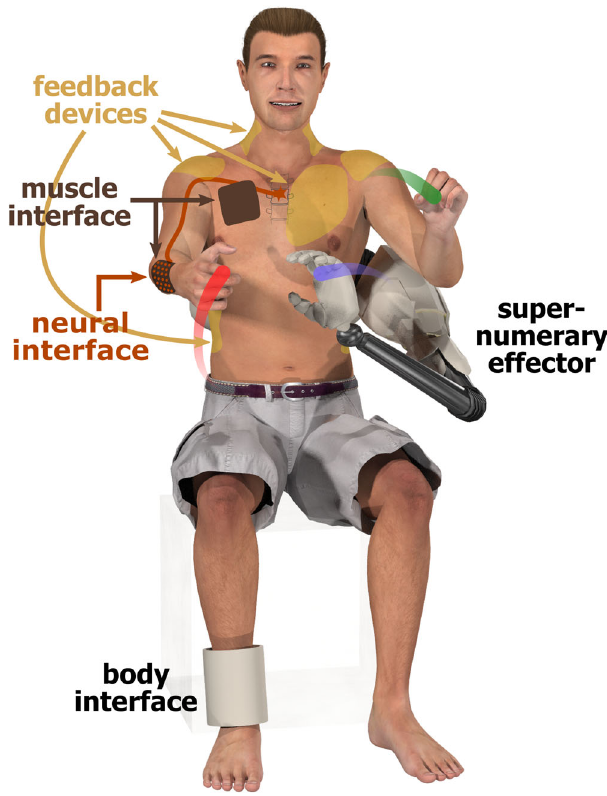
Fig. 3 Interfaces for DoF augmentation ( fi gure by Tobias Pistohl). An individual is augmented using a body, muscle or neural interface to control the supernumerary effector. Sensory information may be provided through feedback devices. The interfaces, supernumerary effector and feedback devices are shown at representative locations. While muscle interfaces are generally noninvasive, neural interfaces can be both invasive or